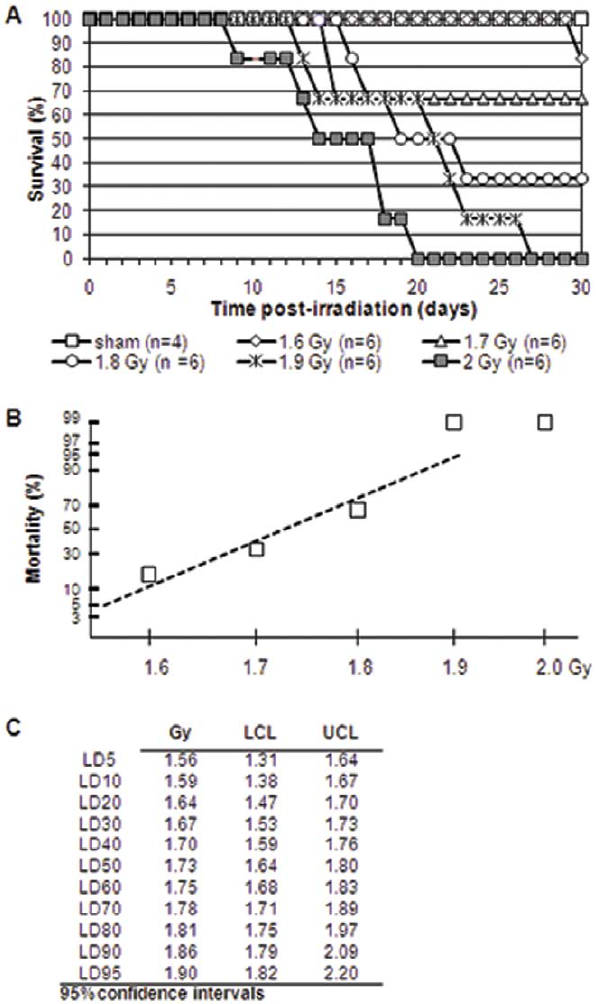
Figure 1. Dose response curves for bilateral gamma-irradiation of Gottingen minipig. Six animals per dose were irradiated with Cobalt-60 (0.6 Gy/min). Survival was followed for 30 days after exposure and data were plotted as Kaplan-Meier curves (Panel A). Probit analysis was used to fit survival curves and calculate dose-response (Panel B) and confidence intervals (Panel